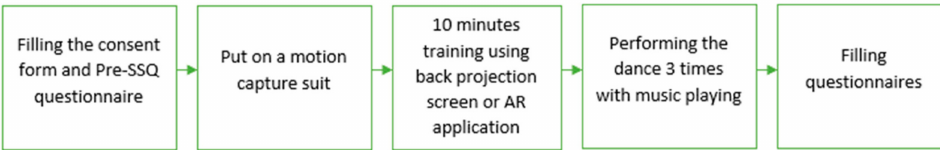
Figure 1. Workflow for learning procedure.